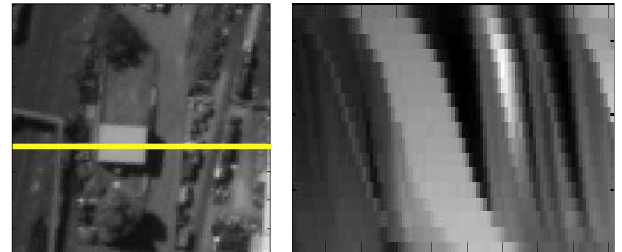
Figure 2. An image zone (U,V) with a homogeneous roof and the epiplanar slice (U, Time) associated to the yellow line. The possible uncertainty of the slopes clearly depends on homogeneity of the roof. Since the sensor motion is neither rectilinear nor at constant velocity, lines are in a wedge shape